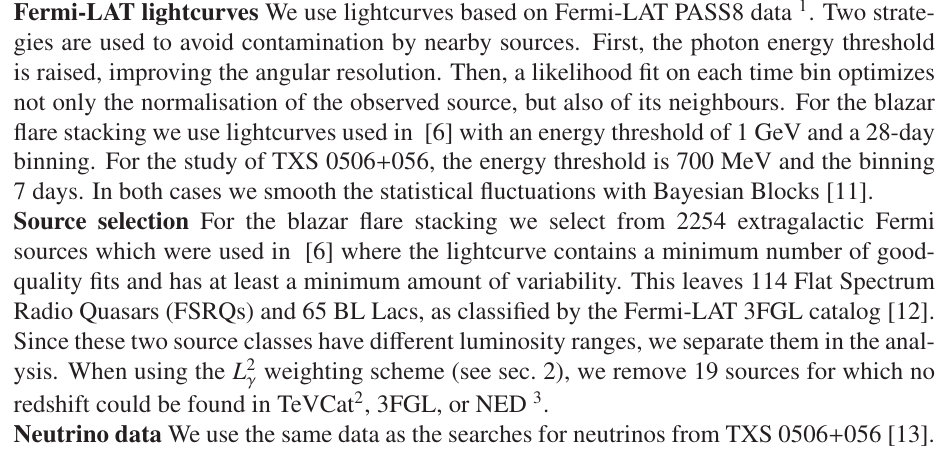
Table 1. Results (best-fit parameters, test-statistic, and p-value) of the TXS 0506 + 056 analysis. Figure 1. Lightcurve of TXS 0506 + 056 for gamma-ray energies > 700 MeV. Grey crosses (NB: not error bars) are the base lightcurve produced by LLH fits to the flux normalisation of the source in 7-day 3 Gamma-ray and neutrino data bins. The blue line is the resulting lightcurve after denoising with Bayesian blocks. Vertical green lines represent the EHE neutrino IceCube-170922A and the time window of the neutrino excess in 2014 / 15.